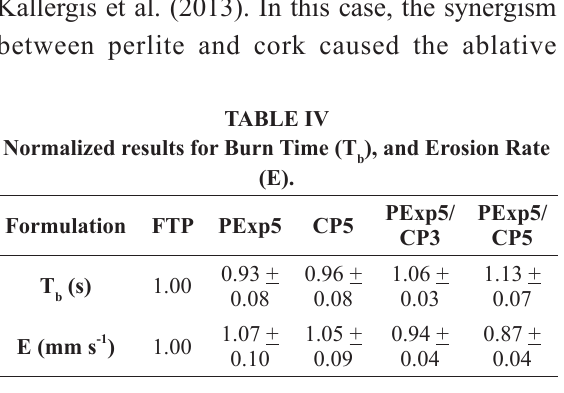
Normalized results for Burn Time (T